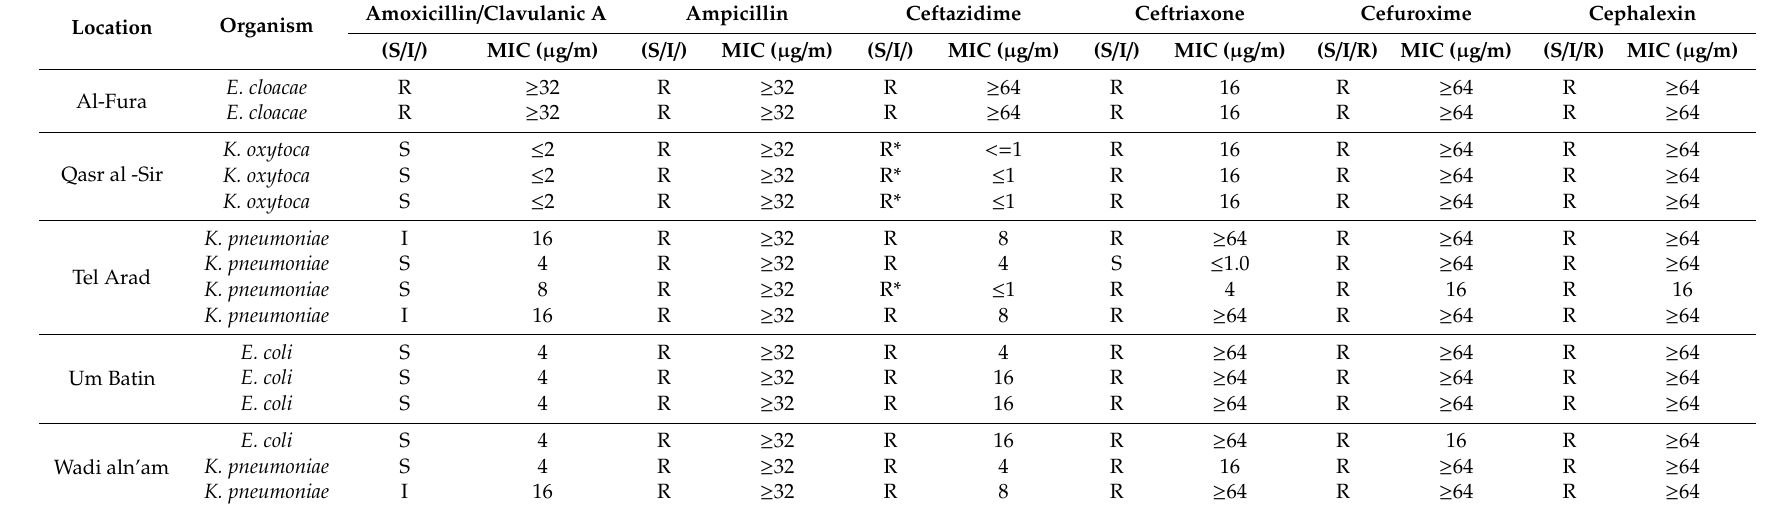
Table 4. Minimum inhibitory concentration (MIC) of various clinically relevant antimicrobials tested on ESBL-positive isolates.